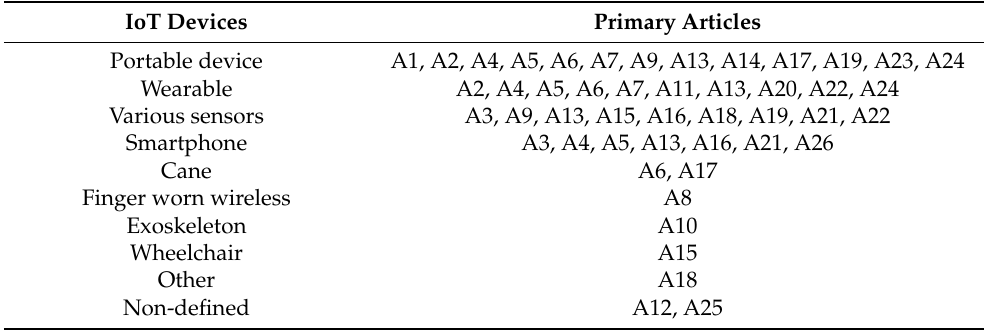
Table 11. IoT devices and their occurrences in the selected articles.